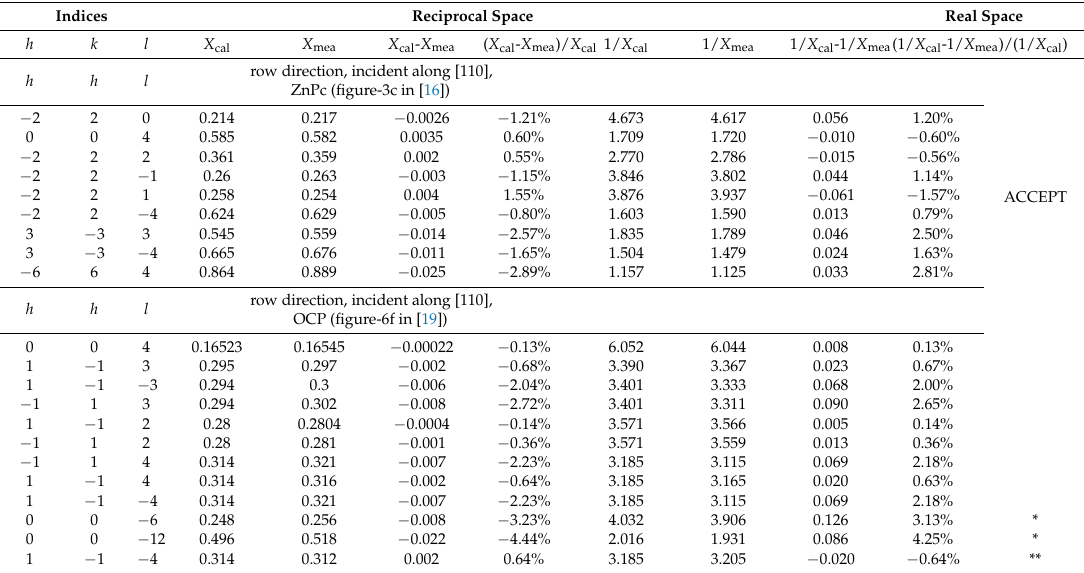
Table 2. Calculated and measured distances between rows and their discrepancies in electron diffraction patterns of ZnPc [16] and Octacalcium phosphate (OCP)